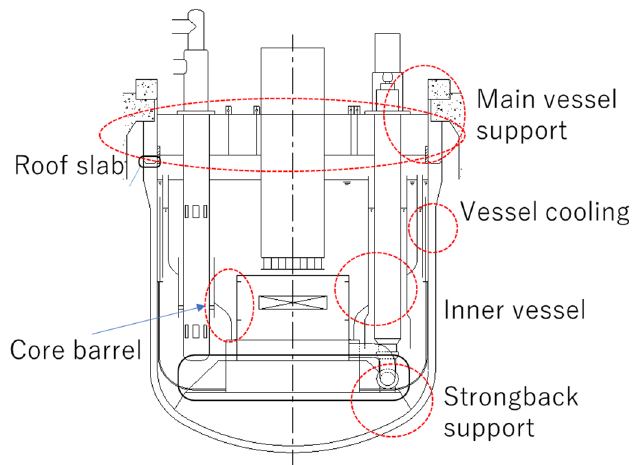
Fig. 4. Discussion parts to improve